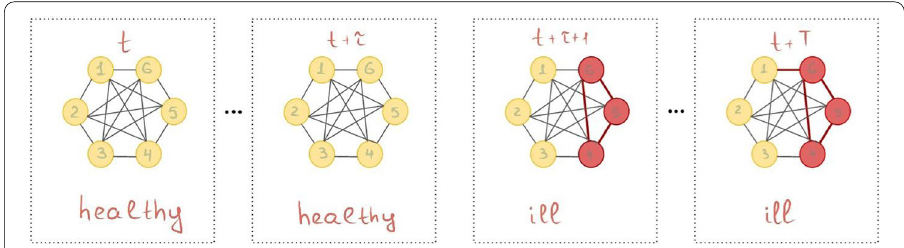
Fig. 1 An example of a time-evolving graph of microbe interactions with two metastable states: healthy and ill . Red color of vertices means that the concentrations of microbes decreased after a person became ill at time t + τ + 1 . This reduction results in the change of the topology of the time-evolving graph characterized by removing the edges between vertices in red and some vertices in